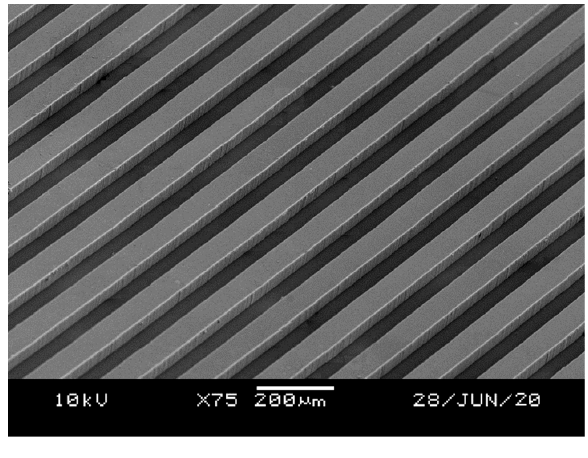
Figure 10. High replication quality of microstructure patterns on each region of a polymer substrate. (When the embossing pressure and embossing time were maintained at 30 kg cm − 2 and 120 s, the practical embossing temperatures of zones A, B, and C were 185.5, 177.1, and 169.1 °C, respectively).